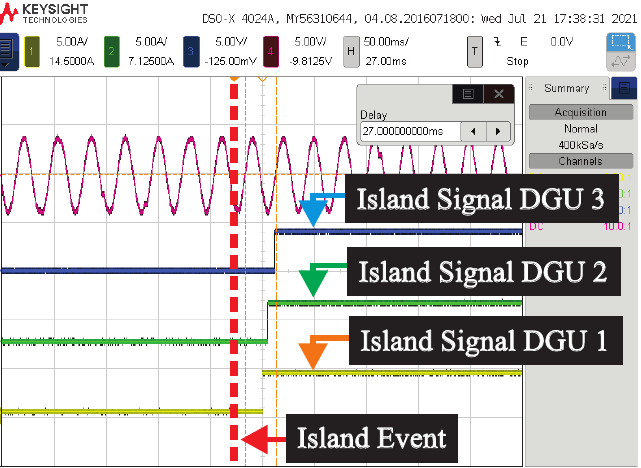
Figure 15. Multiple inverter island experimental results, detection time: (i) DGU1 27 ms; (ii) DGU2 32 ms; (iii) DGU3 40 ms.